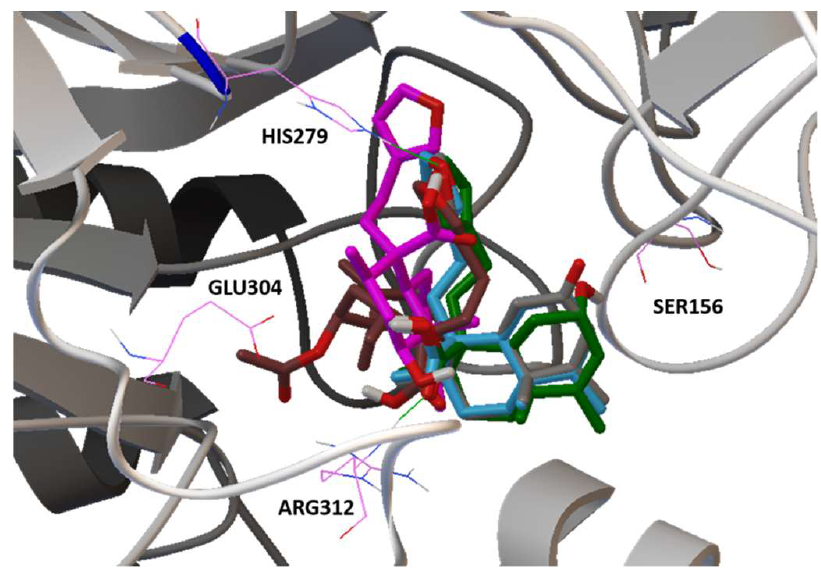
Figure 8. Pharmacophore docking results show the minimized structure of MAL12 with the active compounds 1 – 5 , the furane group forms a hydrogen bond with the NH of the catalytic residue HIS279.